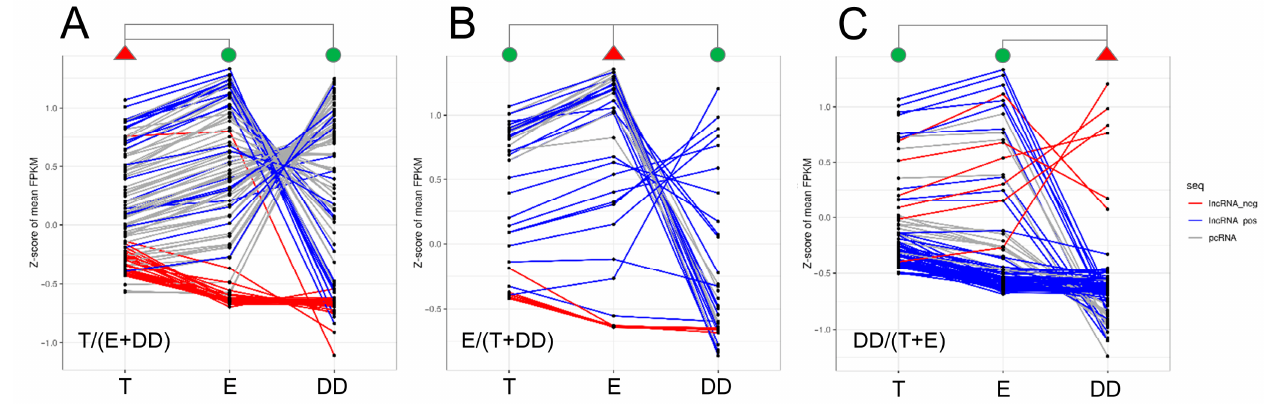
Figure 4. The expression profiles of DELs in three comparisons based on trans-correlated DEGs: ( A ) DEGs of statistically significant expression difference between ductus deferens (DD) and other tissues-testis (T) and epididymis (E), ( B ) epididymis vs. testis and ductus deferens, ( C ) testis vs. epididymis and ductus deferens. The red triangle indicates the tissue against which the expression profiles of the other two tissues (green circles) were compared. The expression profiles of DEGs are presented as grey lines, blue lines are the profiles of positively correlated DELs and red are negatively correlated lncRNAs. Expression profiles (the Z-score values of FPKM-Fragments Per Kilo base of transcript per Million mapped fragments) of all identified DELs are presented as the heatmap in Figure 5. Table 4. Cumulative correlations between DELs and DEGs. Significant correlations between lncRNA and mRNA or proteins in each comparison (number of interactions associated with the sperm motility/all identified interactions).